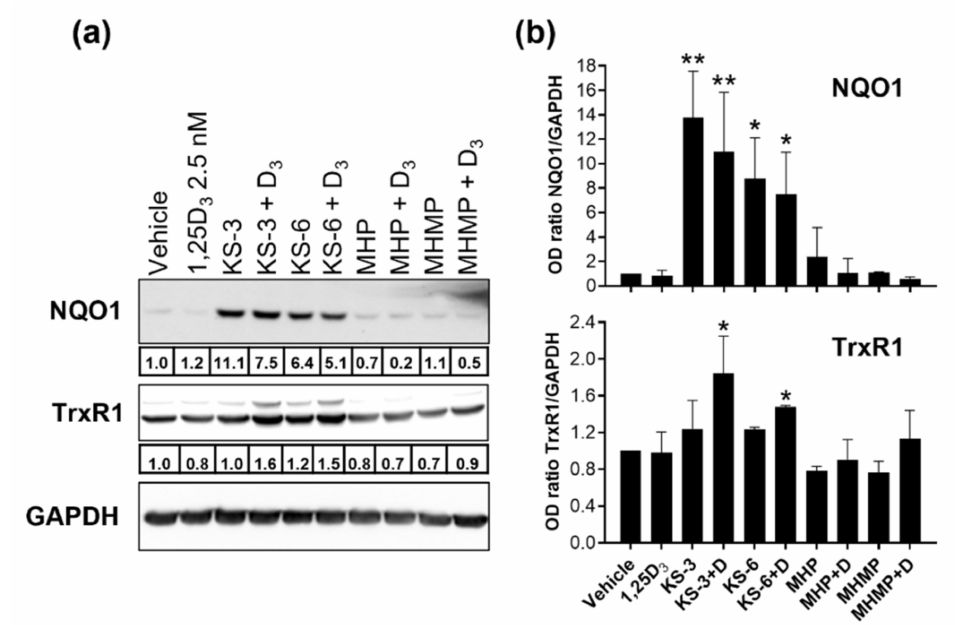
Figure 9. Induction of NQO1 and TrxR1 protein expression in HL60 cells treated with KS-3 or KS-6, but not with MHP or MHMP. Cells were incubated with the indicated phenolic compounds (5 µ M), calcitriol (1,25D 3 or D 3 ; 2.5 nM) or their combinations, for 48 h. ( a ) NQO1 and TrxR1 protein expression analyzed by Western blotting. Integrated Density Values (IDVs) of the indicated protein bands normalized to IDVs of respective GAPDH bands are shown below corresponding blot images. Representative blots of three similar experiments are presented. ( b ) Averaged relative protein levels. The data are the means ± SD ( n = 3). *, p < 0.05 and **, p < 0.01 vs.